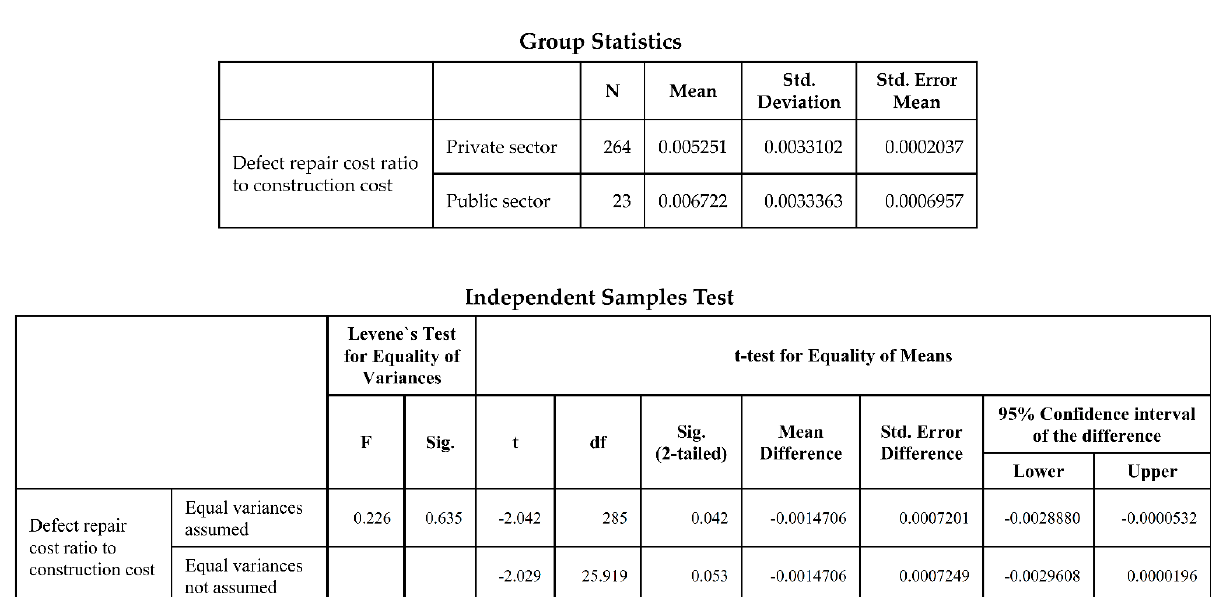
Figure A2. t -test result of project Figure A2. t ‐ test result of project entities.